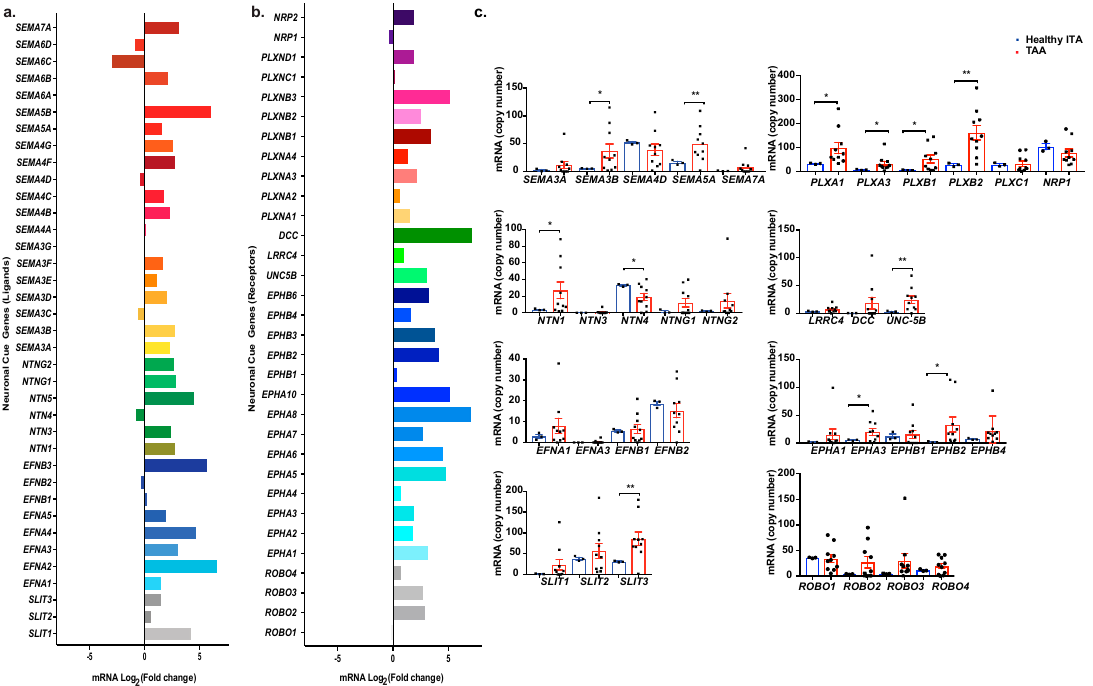
Figure 2. Profiling of neuronal guidance cues in TAA. ( a ) Transcript expression of neuronal cue genes (ligands) in thoracic aortic aneurysm compared to internal thoracic artery. Genes are clustered based on their family. ( b ) Transcript expression of neuronal cue genes (receptors) in thoracic aortic aneurysm compared to internal thoracic artery. Genes are clustered based on their family. ( c ) Profiling and analysis of mRNA copy numbers, identified by RNA-Seq, of the neuronal cue genes involved in axon guidance pathway. Genes are grouped by families of ligands and receptors. * p < 0.05, ** p < 0.01. 2.3. Transcript Analysis and Protein Localization of Netrins and Semaphorins in TAA Tissue